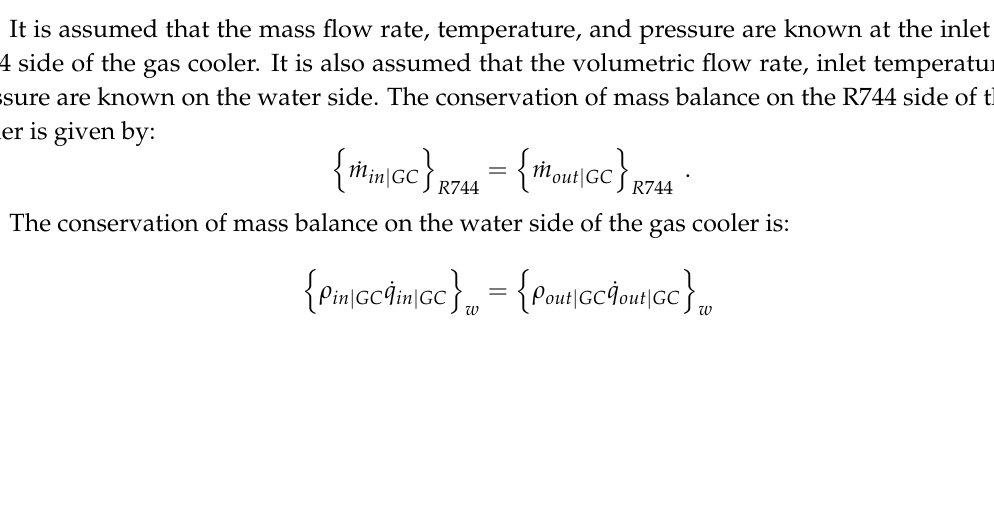
Figure A4. Gas cooler component divided into control volume